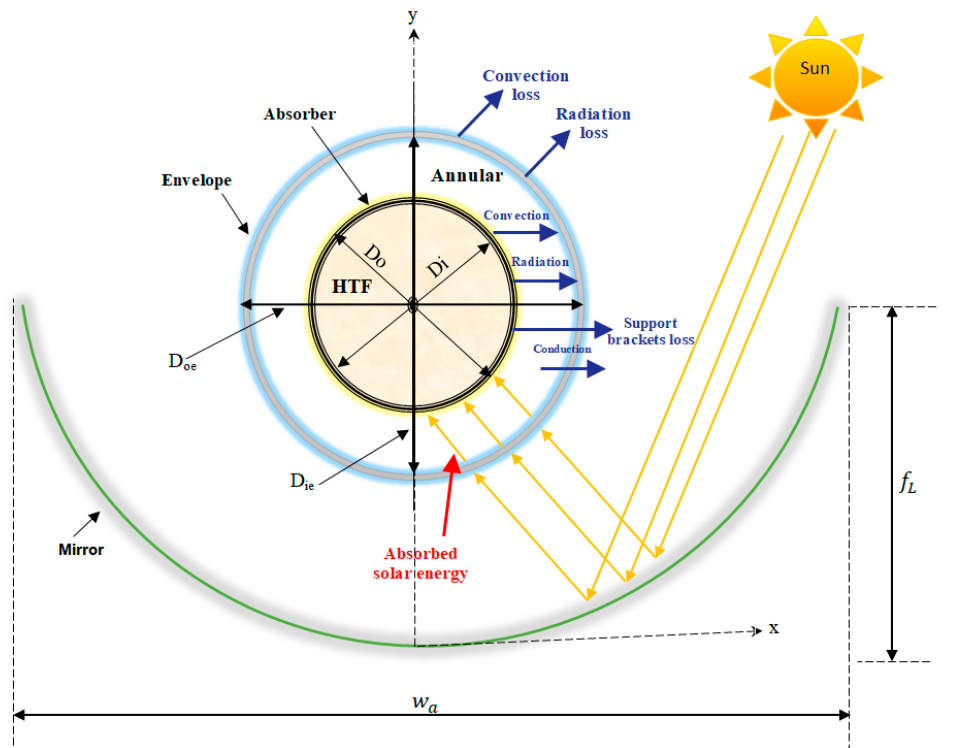
Figure 1. The typical configuration of cross-section of a PTC system.